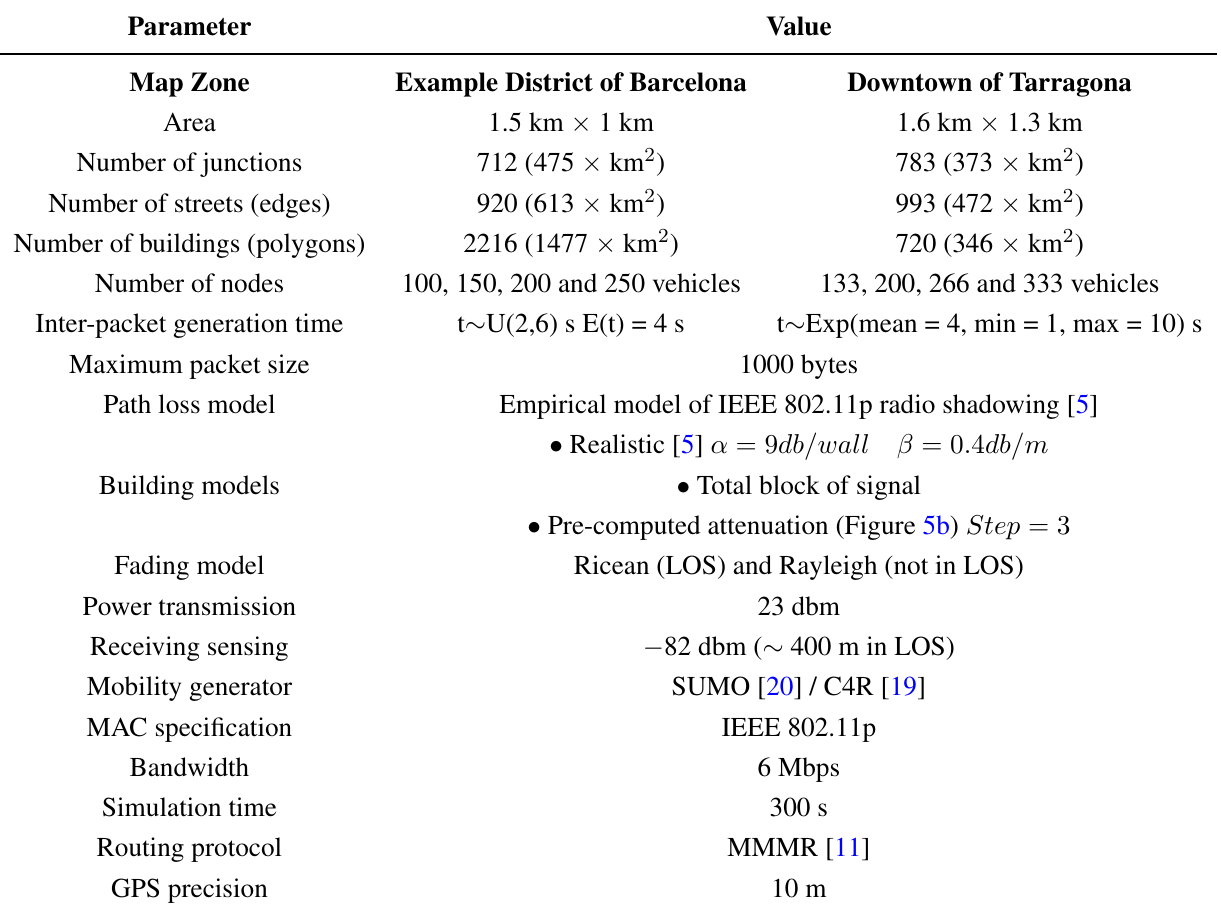
Table 1. Simulation